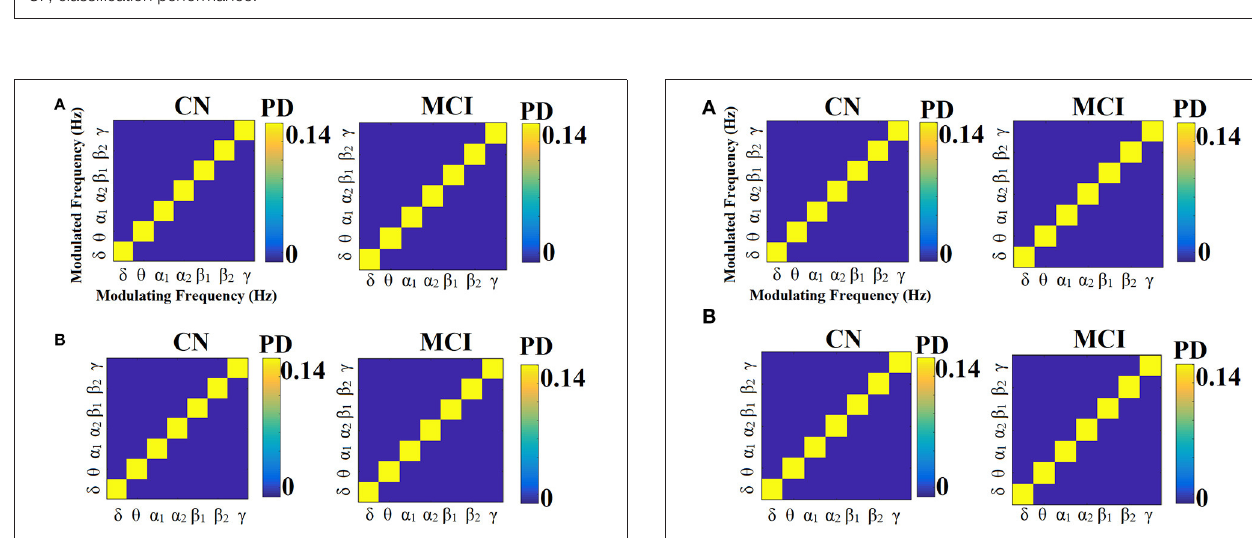
FIGURE 12 | Sensitivity, specificity and classification performance of iPLV using Centroid ROI representation and tensorial treatment of each SL-FCG. (A) Sensitivity, specificity and classification performance for the LOOCV. (B) Sensitivity, specificity and classification performance for the 5-fold CV. Sen, sensitivity; Spec, specificity; CP, classification performance.